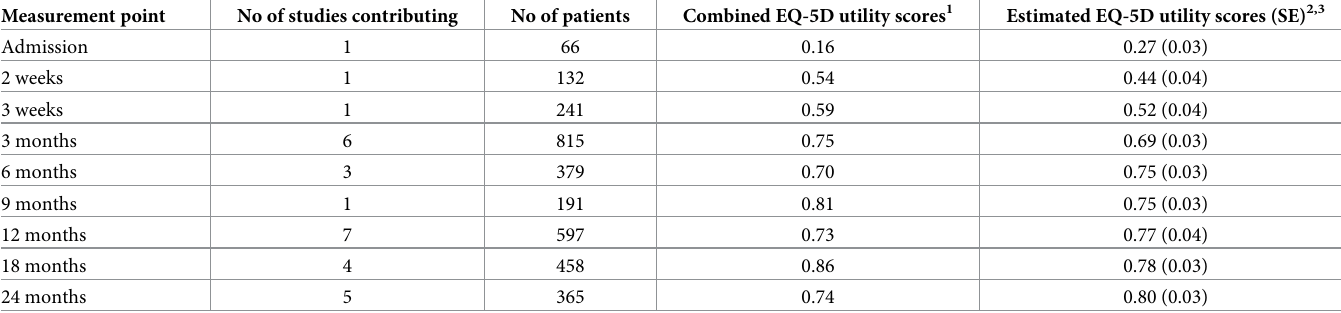
1 Combined EQ-5D utility scores: combined outcomes from the different studies together (without case-mix correction) 2 Estimated EQ-5D utility scores: outcomes as estimated by the recovery model (with case-mix correction)